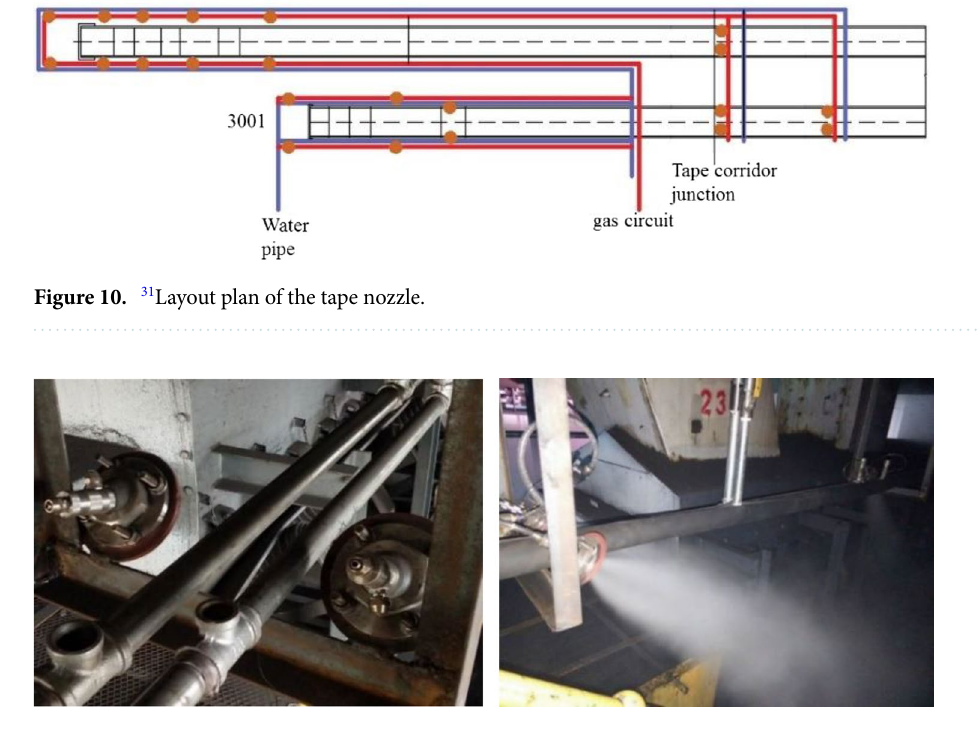
Figure 11. The layout details of the tail nozzle and the atomization